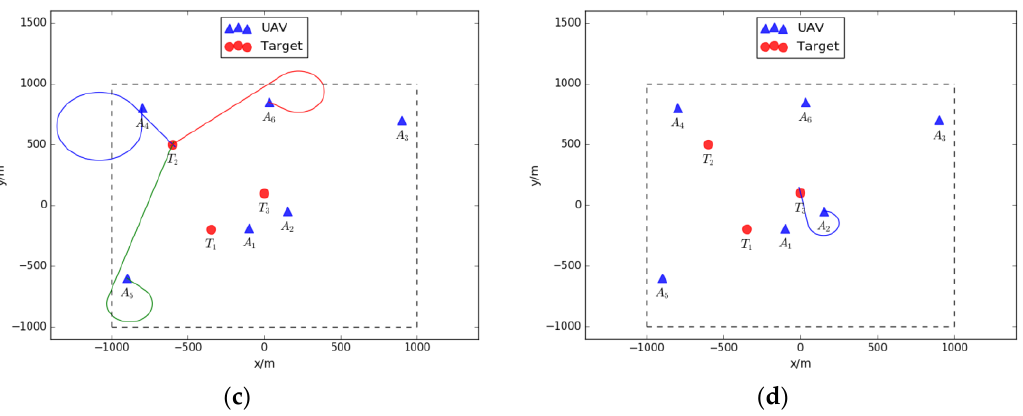
Figure 19. The simulation result: ( a ) overall view of the strategy; ( b ) the strategy for the first target; ( c ) the strategy for the second target; ( d ) the strategy for the third target.